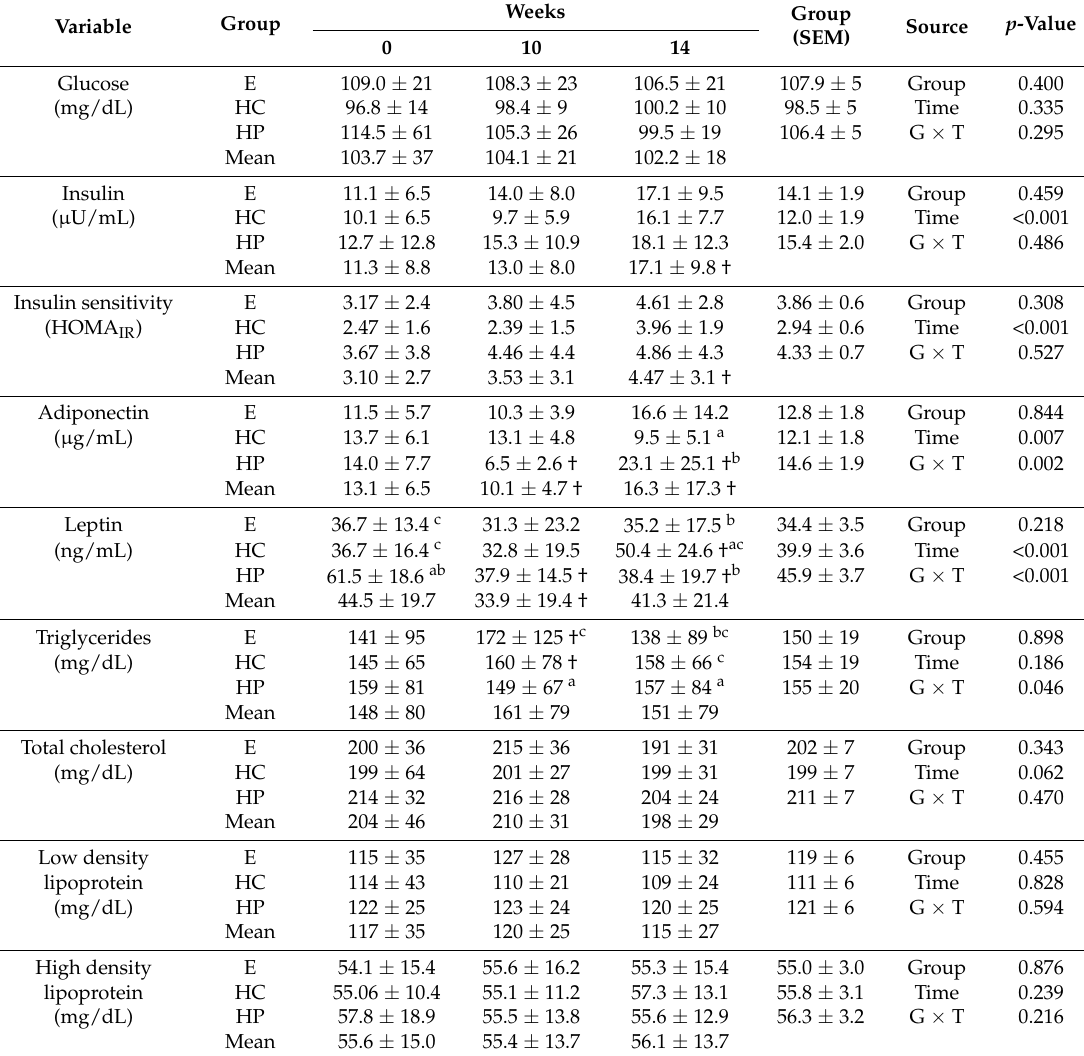
Table 4. Fasting serum hormone and metabolic